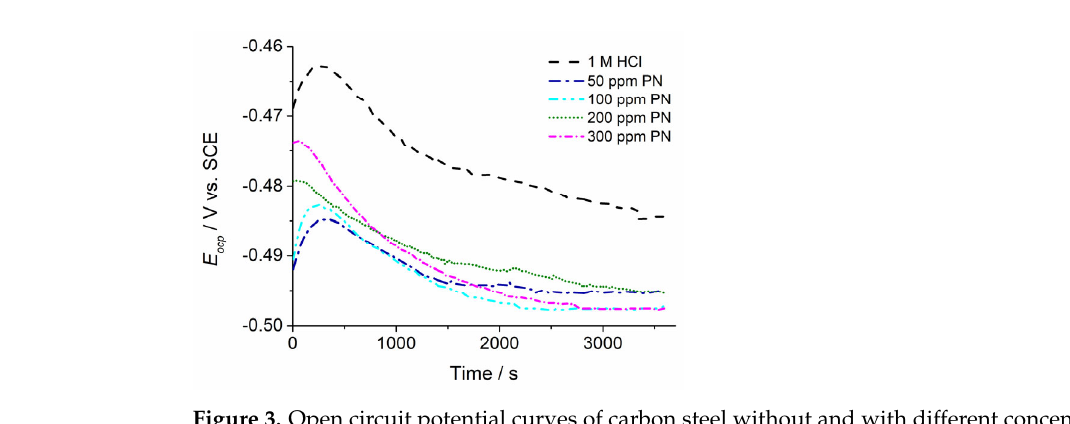
𝑍 (cid:2887)(cid:2900)(cid:2889) (cid:3404) 𝑌 (cid:2868)(cid:2879)(cid:2869) (cid:4666)𝑗𝜔(cid:4667) (cid:2879)(cid:3041)